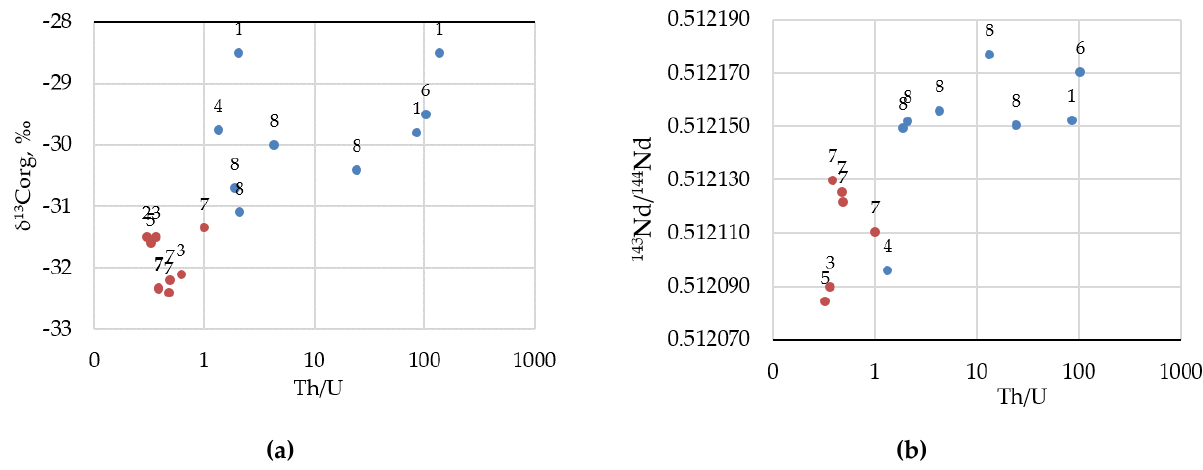
Figure 13. Relations between the Th/U ratio (logarithmic scale) and the isotope composition of organic matter ( a ) and Nd ( b ). The two series of samples represent TOC < 5 wt.% (blue) and TOC > 5 wt.% (red markers), and numbers correspond to geochemical